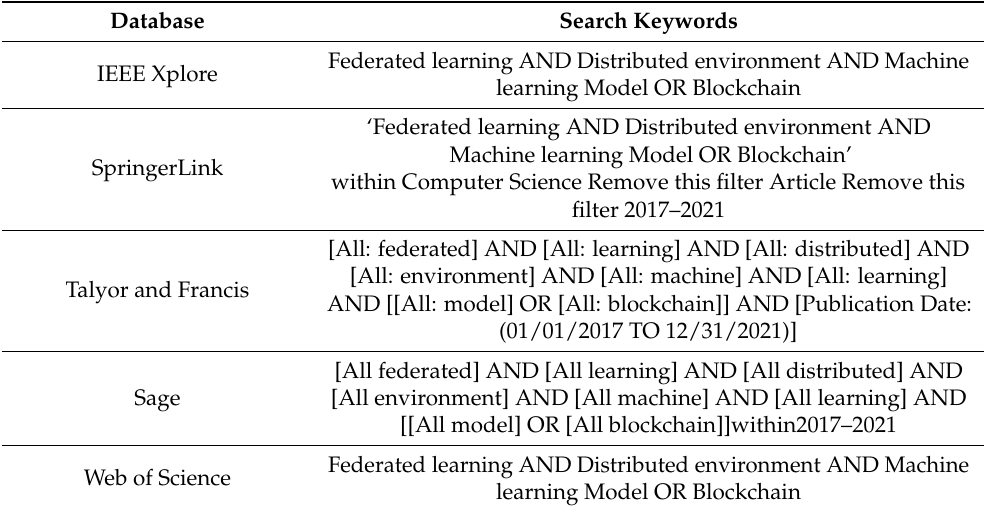
Table 2. Databases and Keywords used for Study Search.